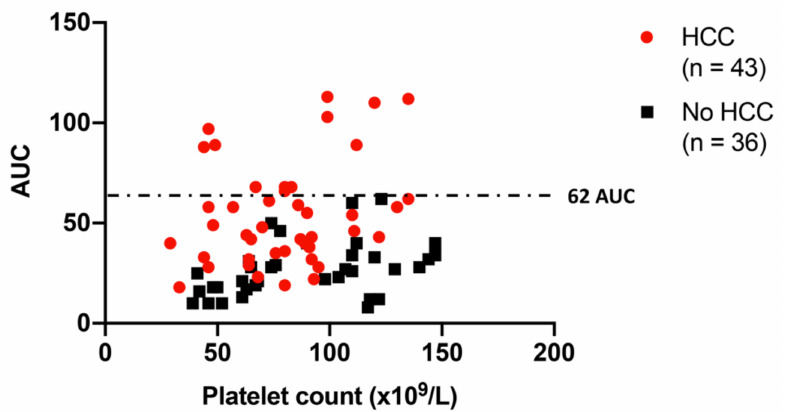
Figure 4. ADP-induced platelet aggregation in thrombocytopenic patients with cirrhosis with (in red) and without (in black) HCC. HCC is associated with relatively higher platelet aggregation at each level of platelet count. No patient with cirrhosis without HCC had levels of ADP-induced platelet aggregation greater than 62 AUC. Red circles: patients with cirrhosis with HCC. Black squares: patients with cirrhosis without HCC.